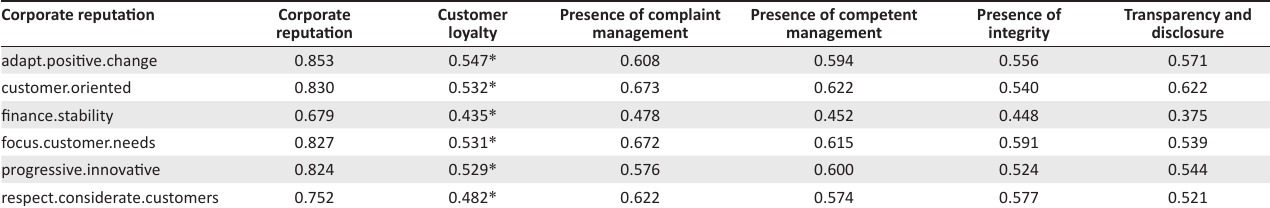
TABLE 7: Cross-loadings (correlations) of bank corporate reputation attributes on customer loyalty.